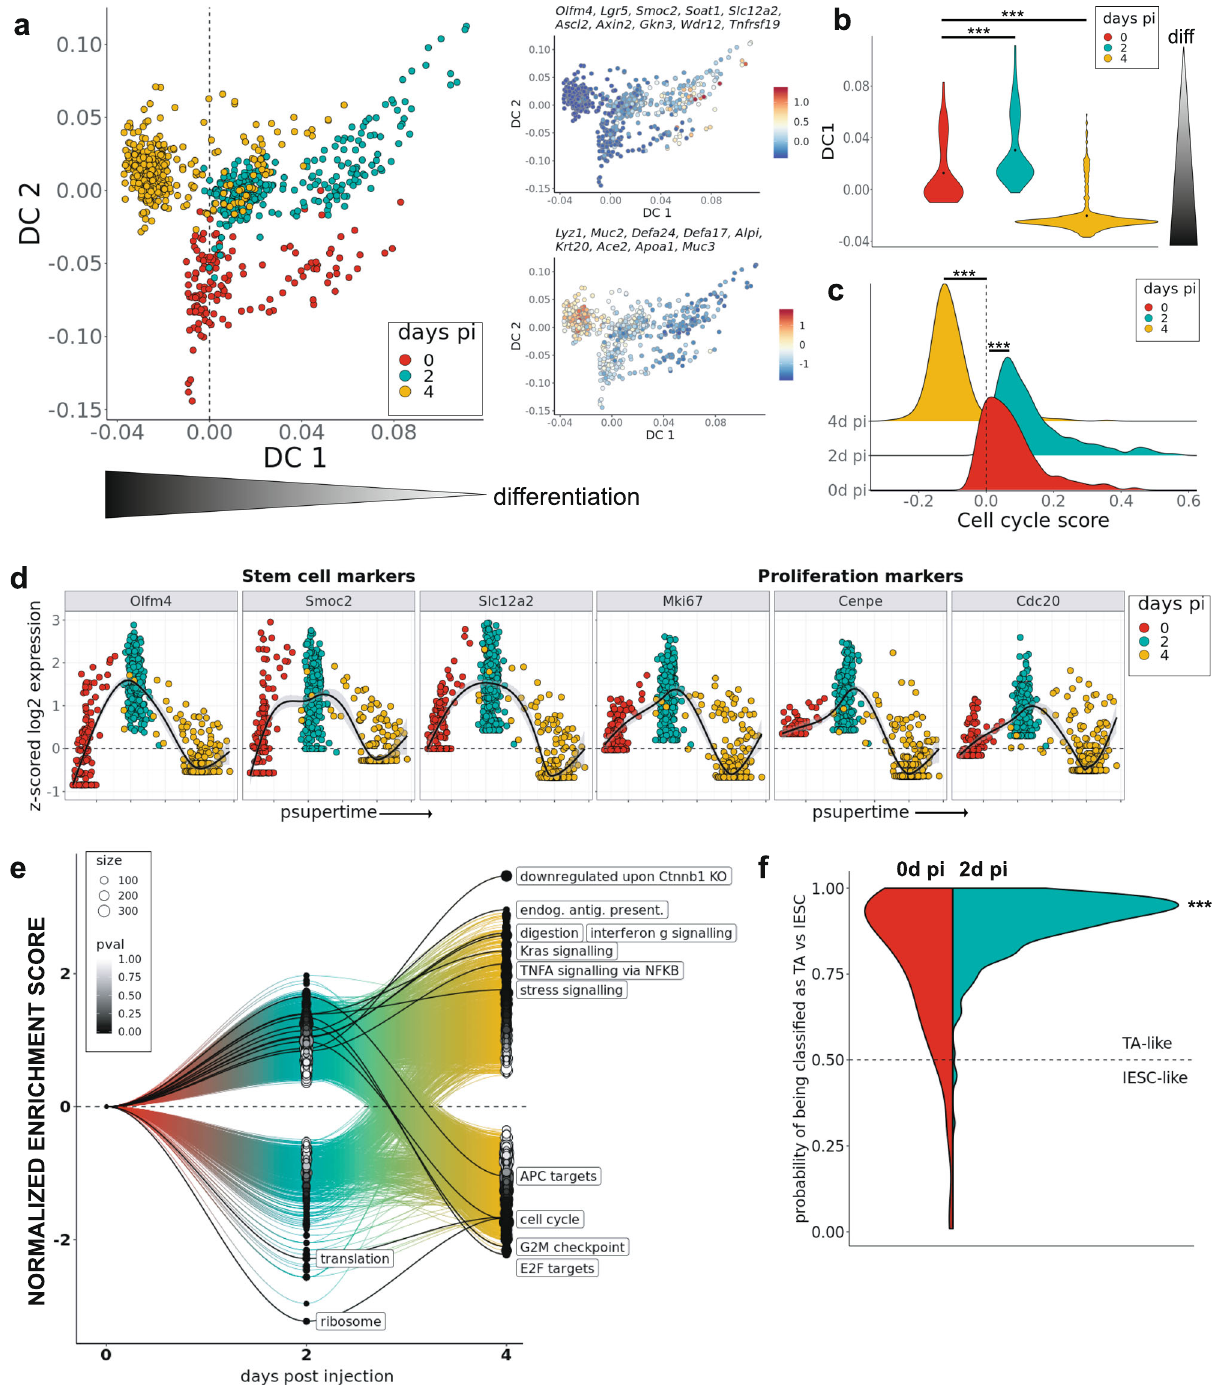
Fig. 4 Myc-E2F-driven proliferation is followed by stress signalling and loss of stem cells in N-terminal mutant (D164A) crypts. a Diffusion map of stem cells and early progenitors (SCEP) cells isolated from D164A ( villin-CreER T2 ;Ctnnb1 D164A/ fl ox , n = 3) crypts 0, 2 and 4d pi and normalized by respective control ( villin-CreER T2 ;Ctnnb1 wt/ fl ox , n = 3). Cells (dots) colored by timepoint after Cre induction (days pi). Diffusion component 1 (DC1) represents differentiation pseudotime. On the right, cells colored by their average expression of stem cell (top) and differentiation marker genes (bottom). b Distribution of DC1 score in normalized D164A SCEP cells over time (*** p < 2.2e − 16, two-sided Wilcoxon test). c Distribution of cell cycle score (average expression of cycling genes) in normalized D164A SCEPs over time (*** p < 2.2e − 16, two-sided Wilcoxon test). d Expression pro fi le of stem cell and proliferation marker genes in normalized SCEP cells ordered along supervised pseudotime (psupertime). Cells (dots) colored by timepoint. e Gene set expression analysis (GSEA) on time-varying genes in SCEPs across timepoints. Normalized enrichment score ( y -axis) over time ( x -axis) of MSigDB gene sets. Dot size indicates the size of the enriched gene set. Dot color indicates p value of enrichment, as calculated by the hypergeometric test. Selected gene sets labeled (identi fi ers in the text). f Distribution of predicted model responses of logistic regression showing a shift of normalized SCEP cells 2d pi from intestinal epithelial stem cells (IESC) to transit ampli fi er (TA) traits. *** p < 2.2e − 16, as calculated by two-sided Kolmogorov-Smirnov test.